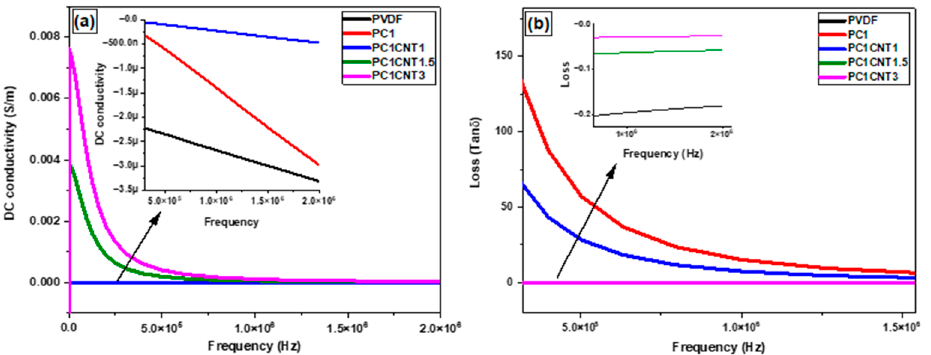
Figure 7. DC Conductivity ( a ), and dielectric loss ( b ) of PVDF and its composites with mono- and bi-nano-fillers consisting of different wt.% of MWCNTs .